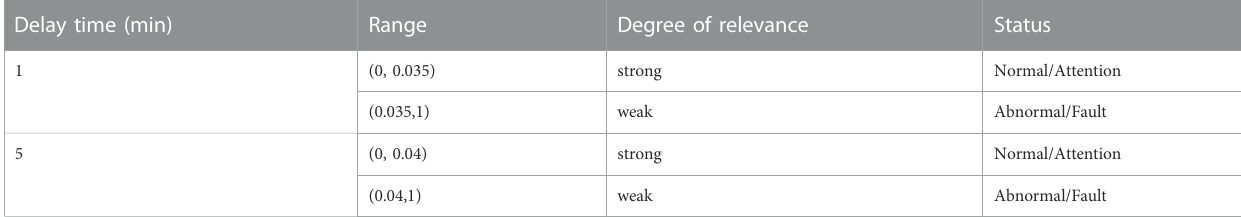
TABLE 4 Mapping of output cross-correlation coef fi cients and wind turbine states. Cross-correlation coef fi cients range (0.85,1) (0.5, 0.85) (0,